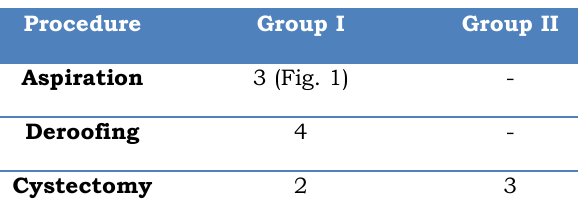
Table 1: Summary of